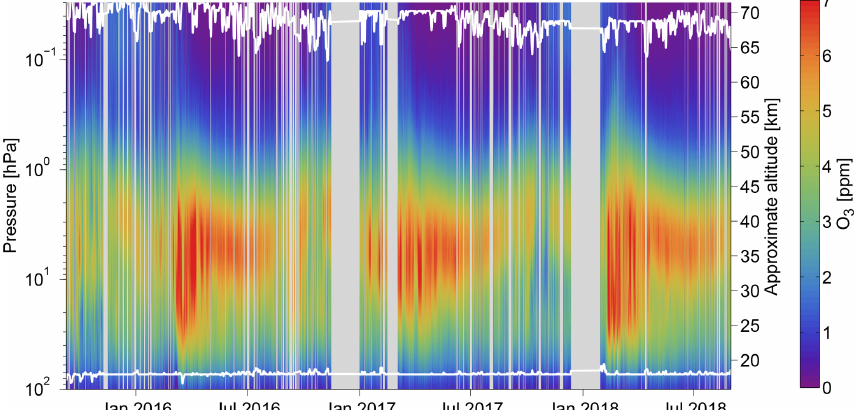
Figure 2. Time series of GROMOS-C ozone profiles from Ny-Ålesund. The horizontal white lines indicate the measurement response of